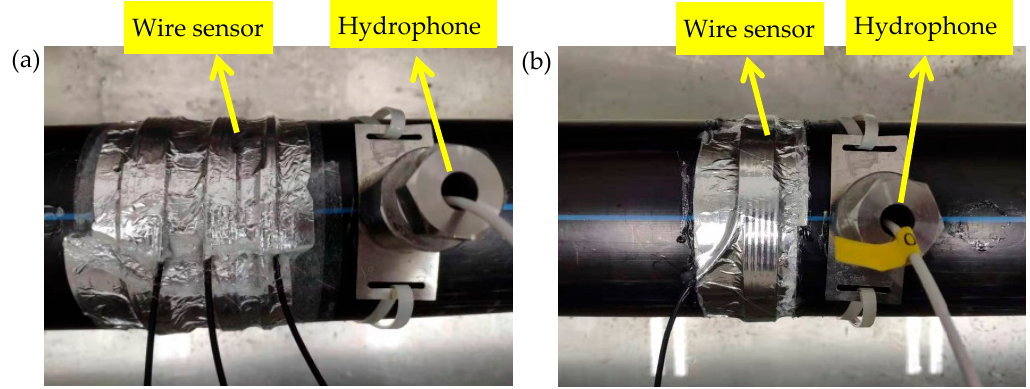
Figure 5. Sensor installation: ( a ) for sensitivity measurements; ( b ) for leak localization measurements.